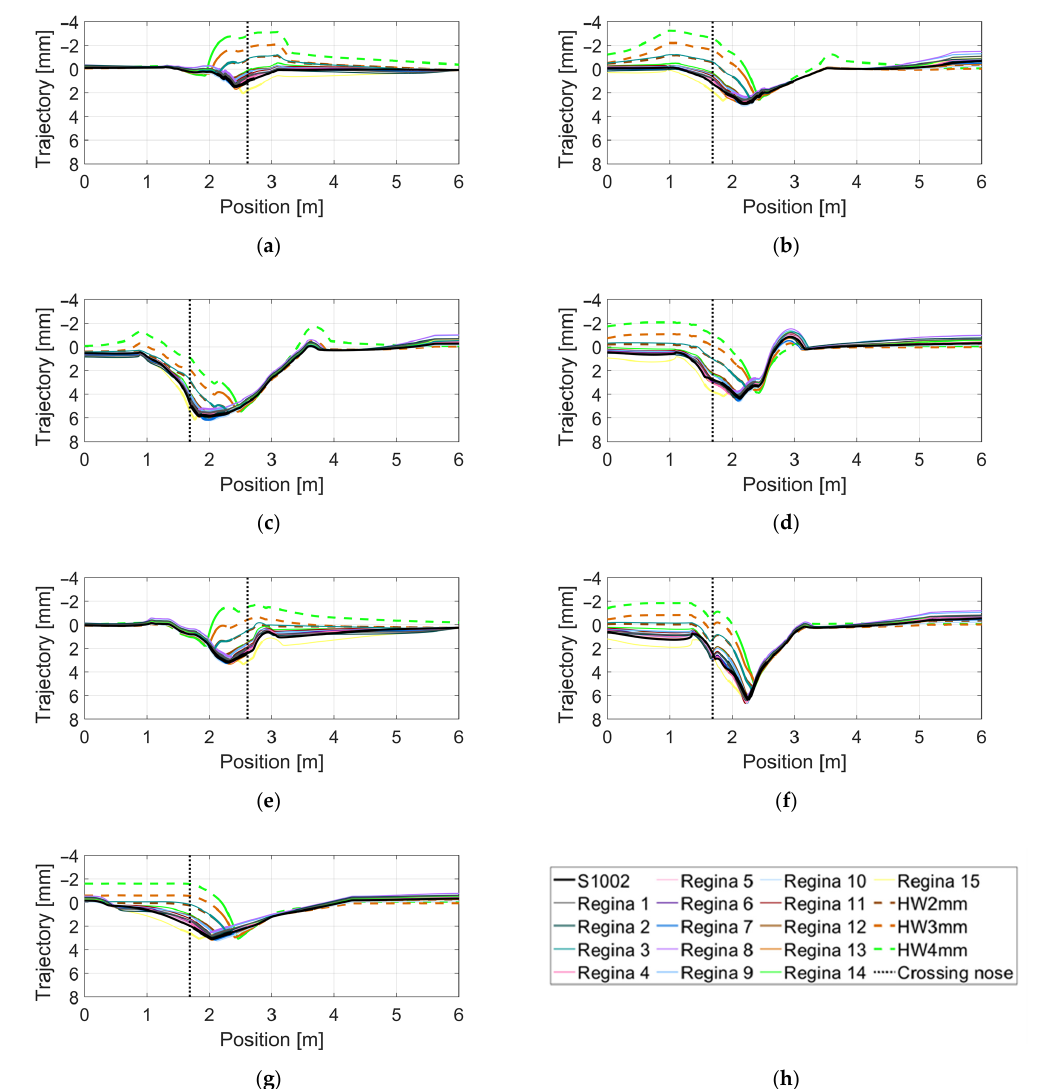
Figure 12. Calculated trajectories of relative vertical wheel–rail displacement for 19 different wheel profiles in seven dif- ferent crossings: ( a ) HO 21B, ( b ) HO 22A, ( c ) SG 21A, ( d ) SG 21B, ( e ) VAD 102, ( f ) VAD 131, ( g ) Nominal crossing geometry, ( h ) wheel profile legend (vertical, dotted line is the tip of crossing nose).